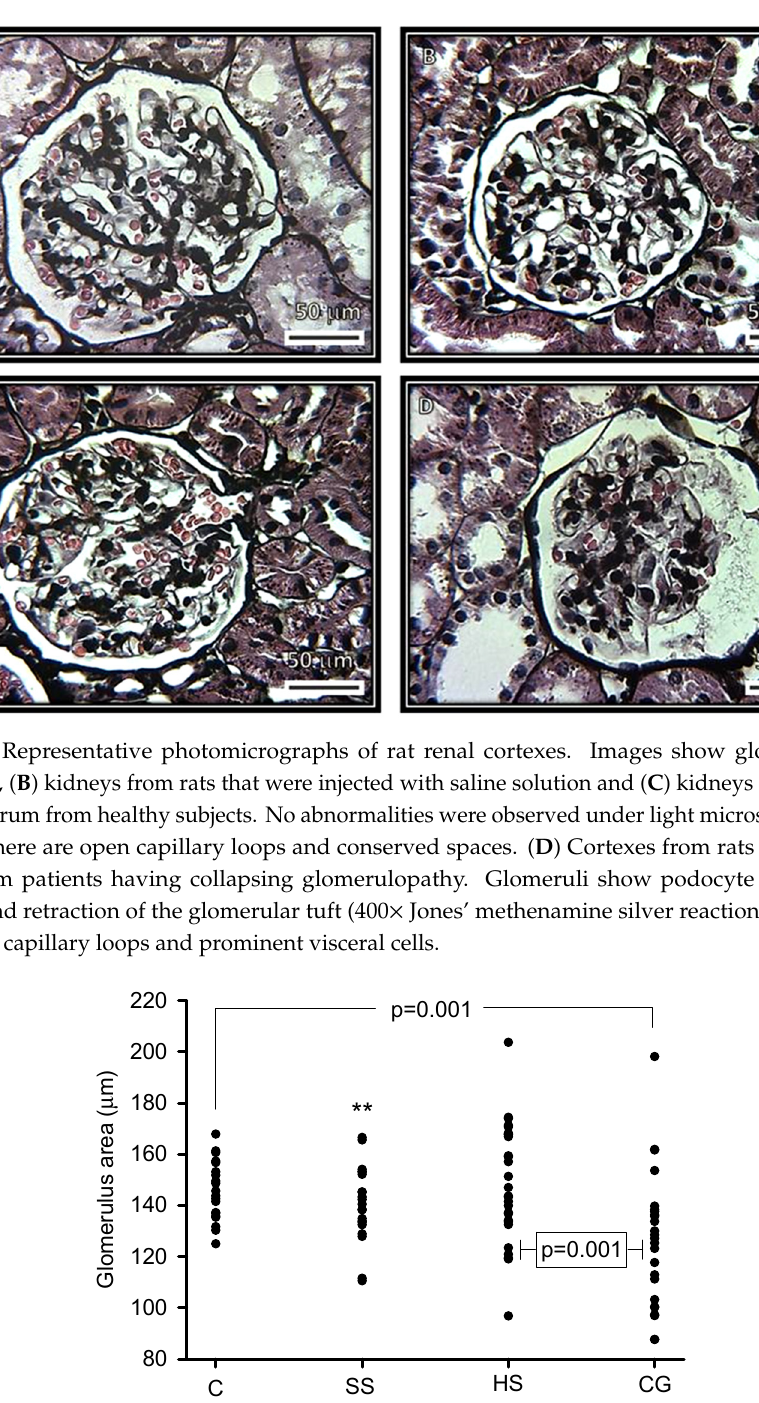
Figure 5. Densitometric analysis of the glomerular area in the experimental groups. The collapse of the glomerulus was evident in CG group in comparison to the C, SS and HS groups; ** SS vs. CG, p = 0.009.